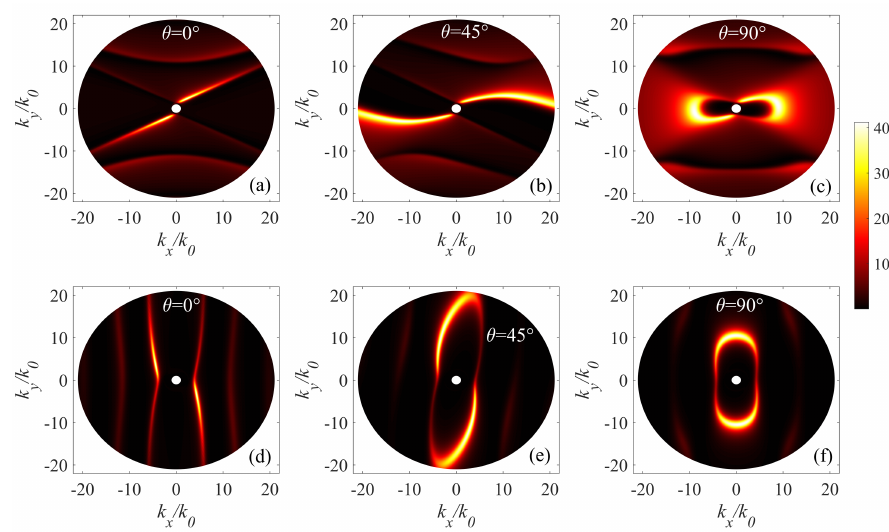
Figure 6. Hybridization dispersions of the α - MoO 3 / α - MoO 3 /InAs structure varying with wavevector components k x and k y at the wavenumber of 600 cm − 1 ( a – c ), 840 cm − 1 ( d – f ) with an external magnetic field equal to 2T. The thickness of top α - MoO 3 layer is 50 nm, the other parameters are the same as those used in Figure